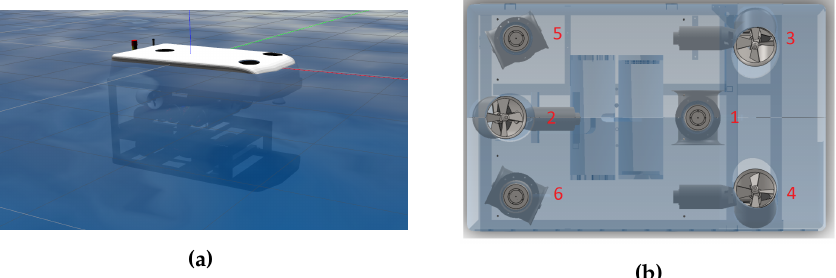
Figure 5. The RexROV 2 model available in the UUV simulator. ( a ) The RexROV 2 shown in the Gazebo client. ( b ) Thruster layout of the RexROV 2 (top view).